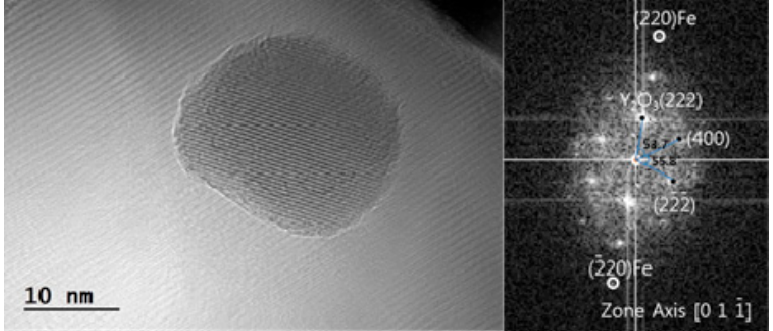
Figure 7. The HRTEM study results for Y 2 O 3 -type oxide particles in mechanically alloyed Fe-10Cr-5Y 2 O 3 powder after heat treatment at 1150°C for 1